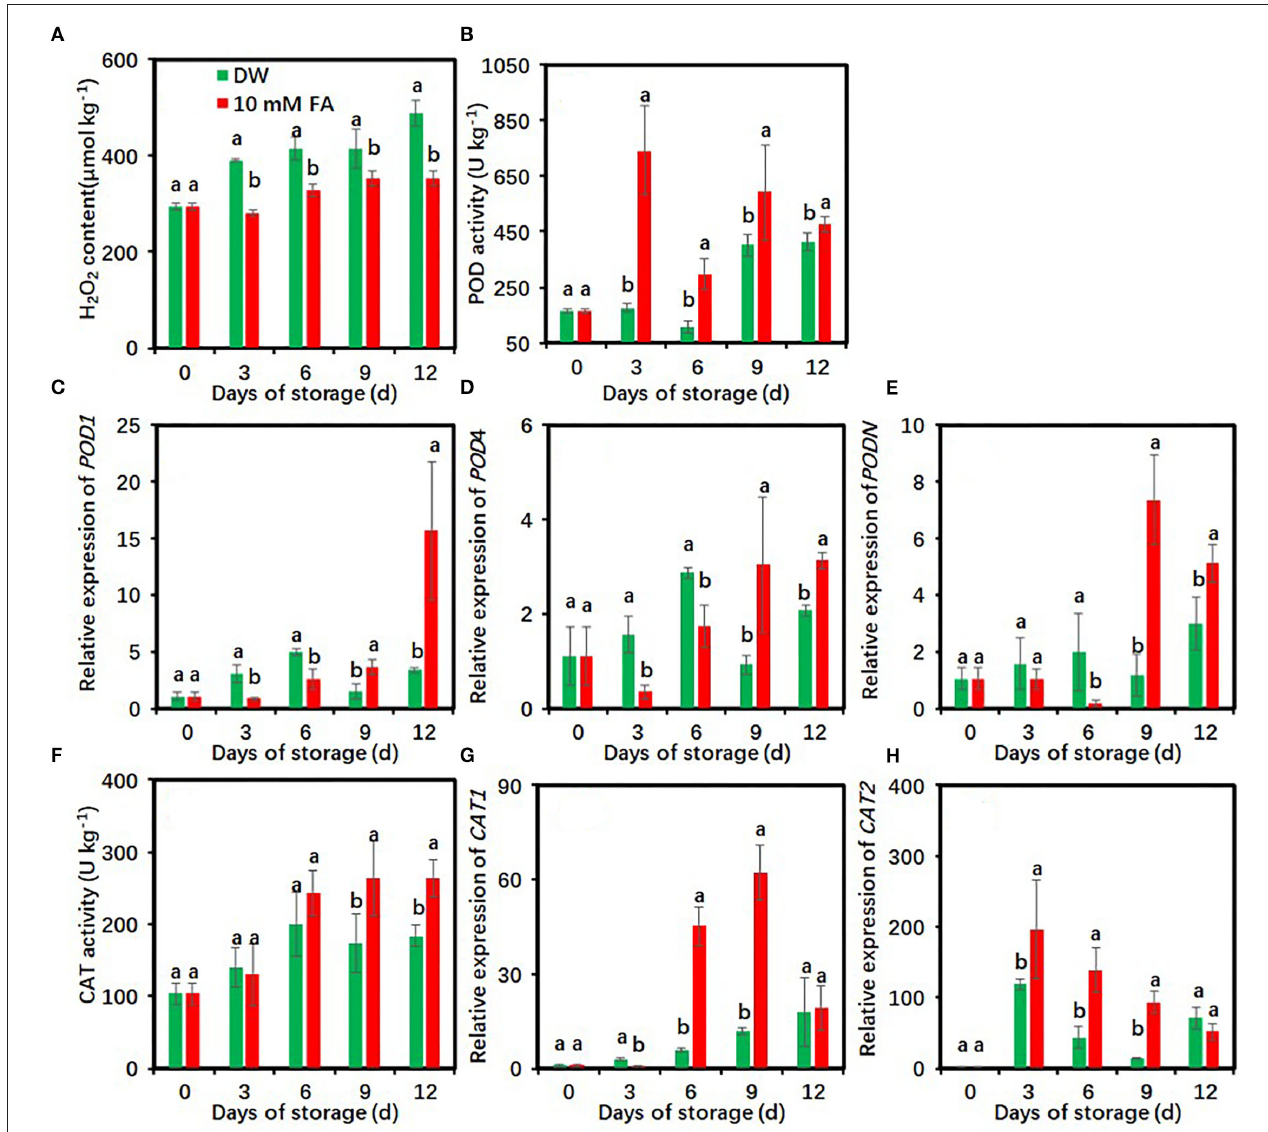
FIGURE 5 | Effects of 10mM FA treatment on hydrogen peroxide contents (A) , and the activity and gene expression of POD (B–E) and CAT (F–H) in taro slices during storage at 5 ◦ C. Each value is presented as means ± standard deviation (SD, n = 3). Statistical differences ( p ≤ 0.05) between the control and 10mM FA treatment at the same time point are analyzed and indicated using different letters above the